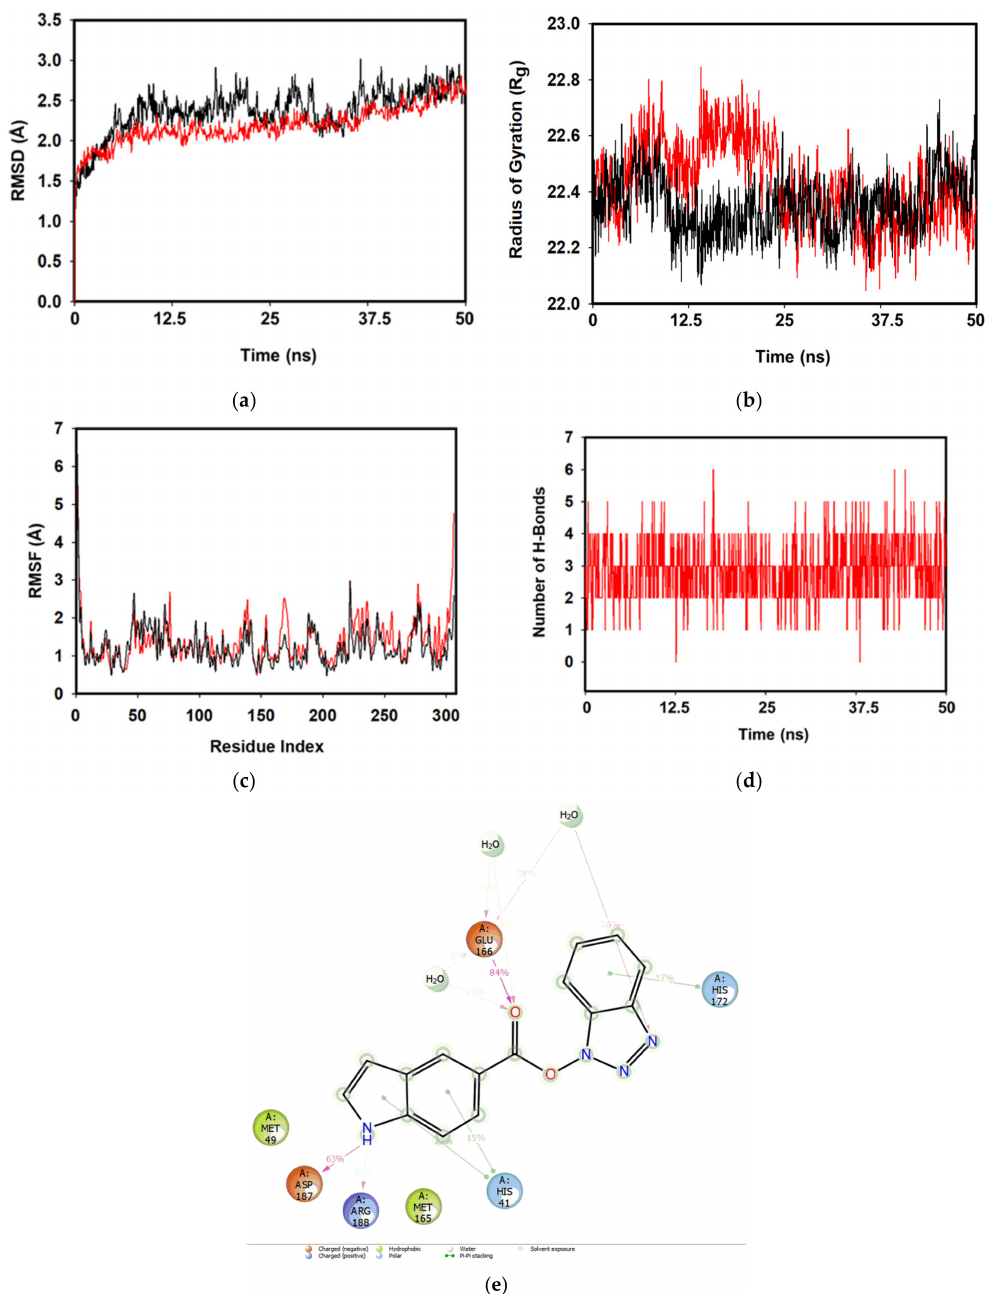
Figure 4. RMSD plots of ( a ) apo-Mpro (red) and 1 bound Mpro complex (black) implying overlapping vibrations and smooth interactions between protein and ligand. ( b ) Radius of gyration of apo-Mpro (red) and 1 bound Mpro complex (black), owing to their compactness after 50 ns simulation. ( c ) RMSF plots apo-Mpro (red) and 1 -Mpro (black) displaying least fluctuations throughout the 50 ns convergence during simulation. ( d ) H-bonds plot displaying the number of H-bonds formed during to total time scale of 50 ns of simulation. ( e ) Two-dimensional interaction plot of Mpro with 1 displaying the involvement of amino acids making varying interaction after 50 ns of simulation. The average H-bonds count displayed three numbers of bonds formation from the beginning to end of the simulation with the ligand 1 molecule (Figure